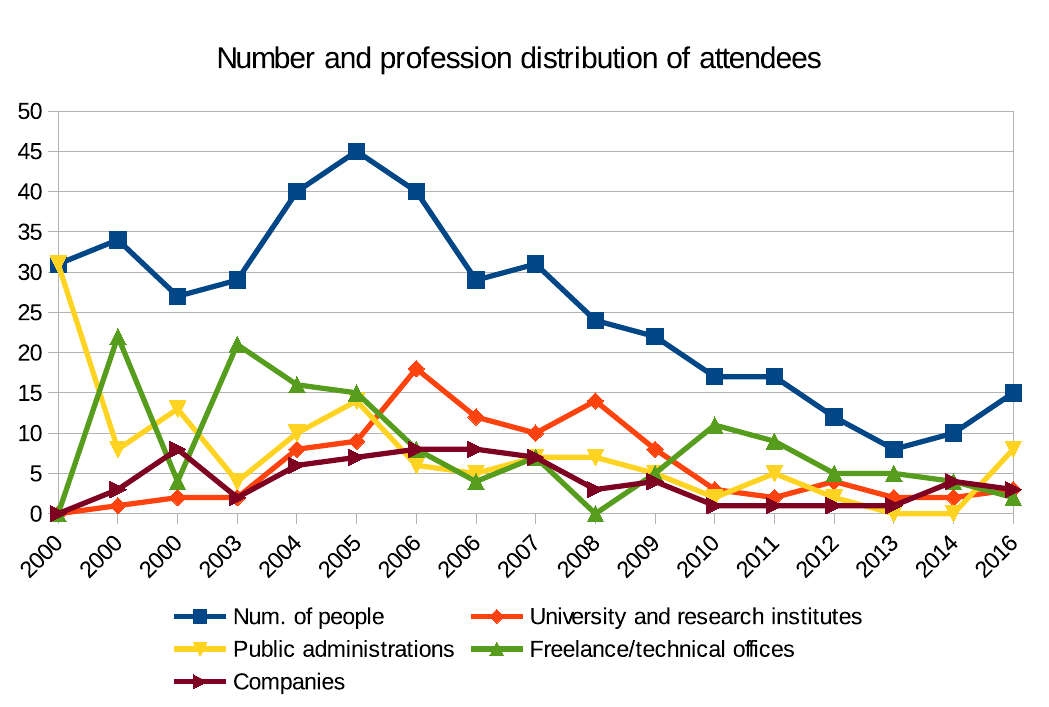
Figure 4. Distribution with respect to profession of the classes of trainees for the courses for professionals in the GIS field at